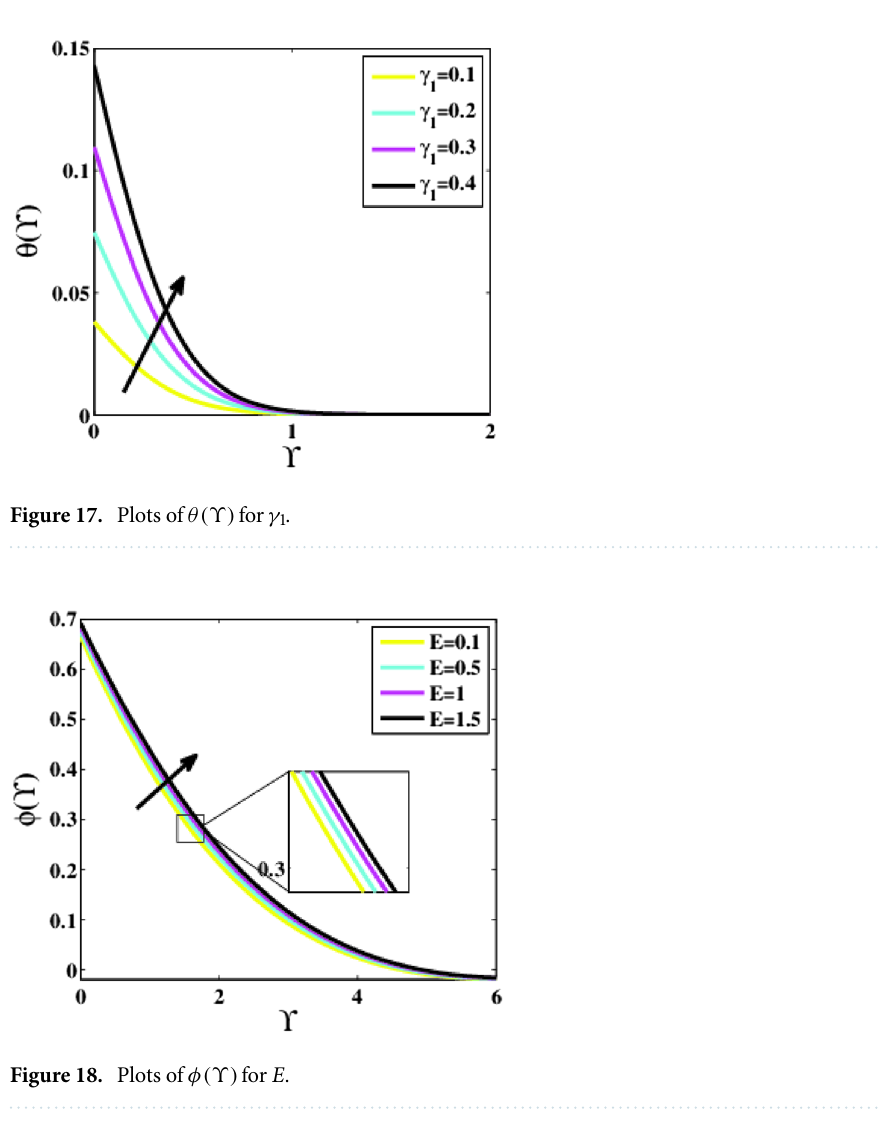
Figure 16. Plots of θ(ϒ) for Pr